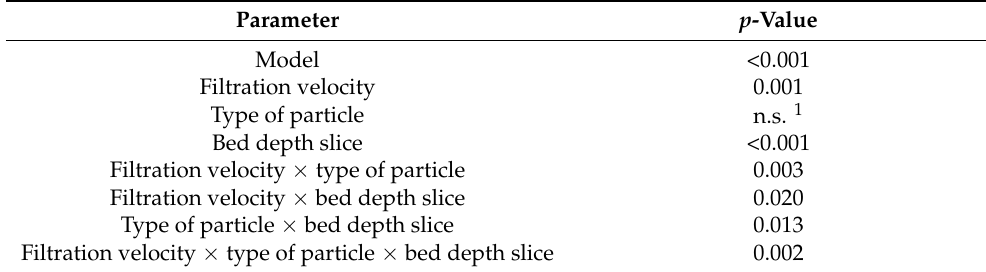
Table 3. Significance levels ( p -value) of the statistical model, each factor (filtration velocity, type of particle, and bed depth slice) and the double and triple interactions for explaining the ratio of total solids retained per mass of bed